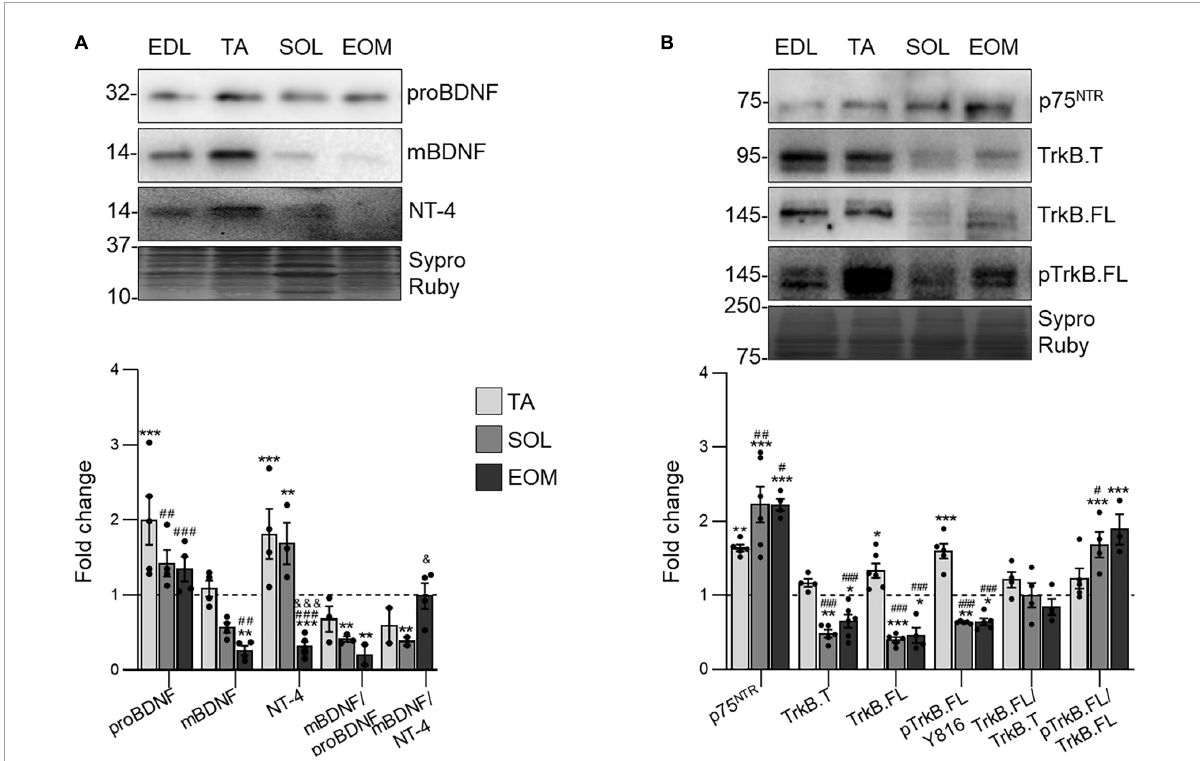
FIGURE2 NTFs and receptors expression changes in EDL, TA, SOL, and EOM of Sprague Dawley rats. Western blot analysis and data quantification of (A) neurotrophic factors and (B) neurotrophic factor receptors protein levels in different muscles. Sypro Ruby images show the region surrounding each protein of interest despite the bands’ optical densities being normalized using the full length of the lanes. Data are presented as mean ± SEM. Each circle in the bars is the mean result of one animal. * P ≤ 0.05; ** P ≤ 0.01; *** P ≤ 0.001; *against EDL, # against TA, & against SOL (Kruskal–Wallis test and Dunn’s post-hoc test). EDL, Extensor Digitorum Longus; TA, Tibialis Anterior; SOL, Soleus; EOM, Extraocular Muscles. Graphs done with GraphPad Prism software, San Diego,